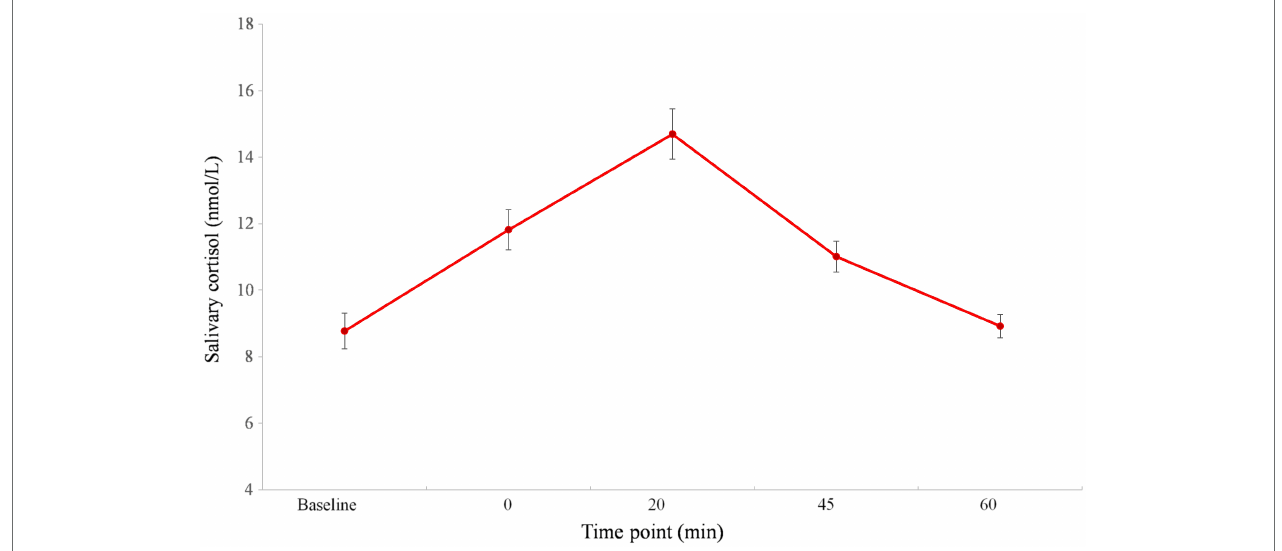
FIGURE 2 | Cortisol response before, during, and after TSST (adapted from Xin et al., 2017). Error bars show the standard error of the mean. The number 0 indicates the end of the TSST.